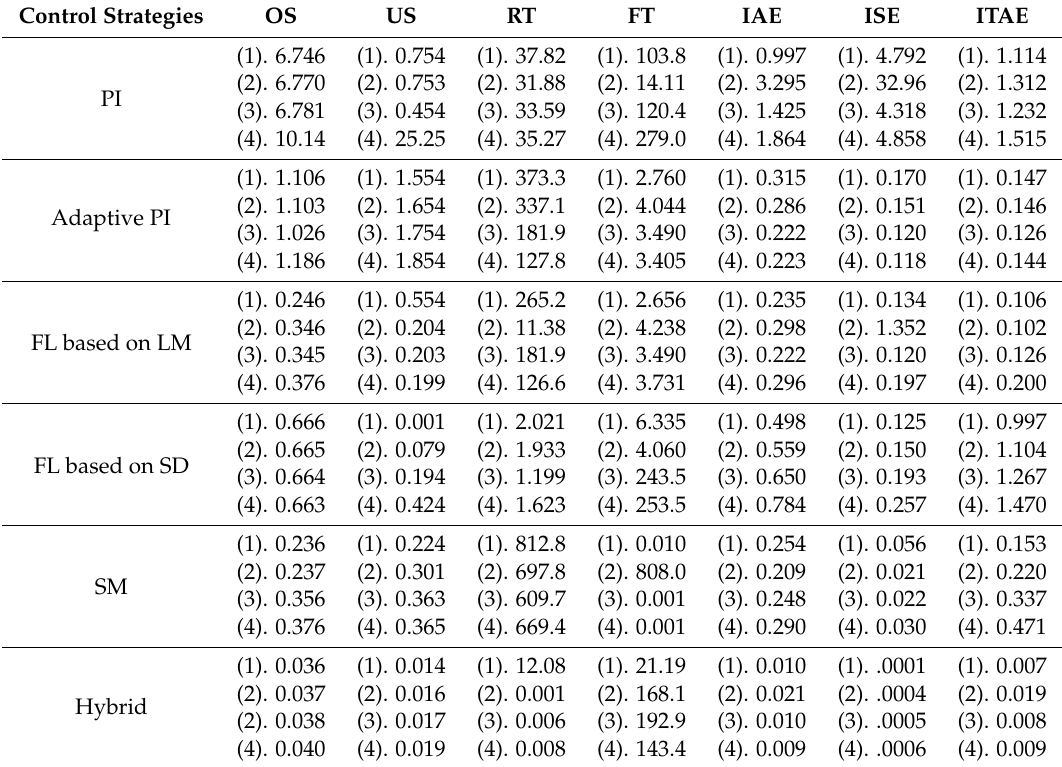
Table 1. Performance assessment of designed